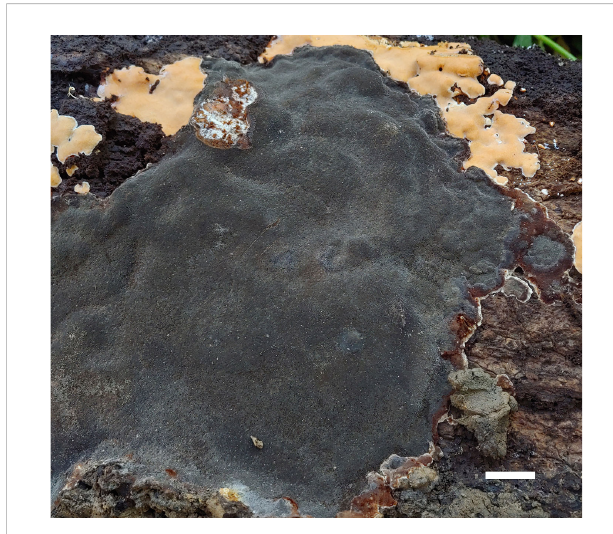
FIGURE 5 A basidiomata of Pyrrhoderma nigra (MO 489730). Scale bar: 1